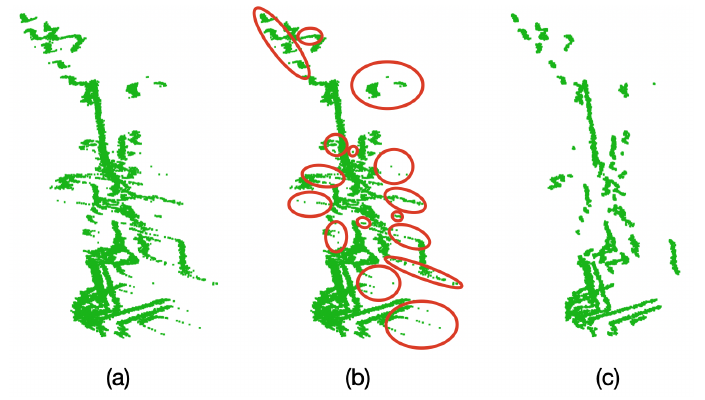
Figure 14. Oversampling and outlier removal on the the point clouds. (a) Raw point cloud of the Limonaria plant. (b) Regions of the point cloud where unwanted points are found (in red). (c) Point cloud after oversampling, averaging and filtering.